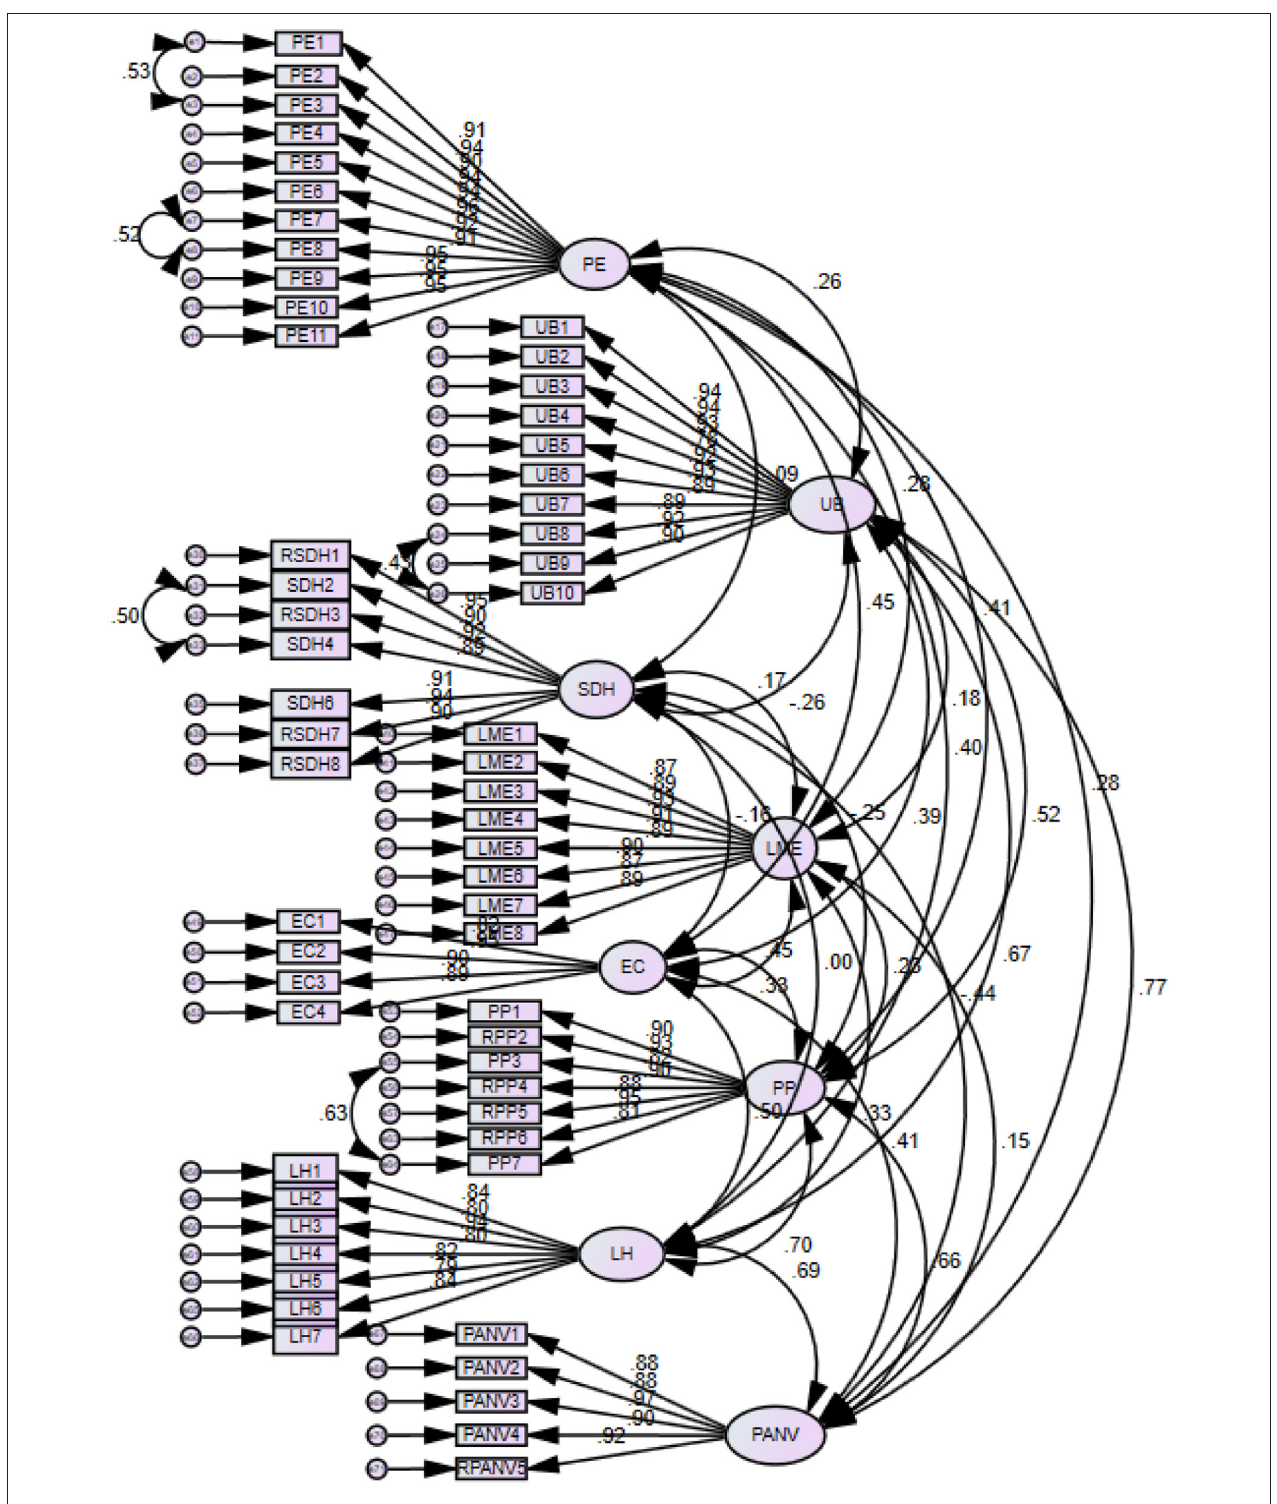
FIGURE 2 | Confirmatory factor